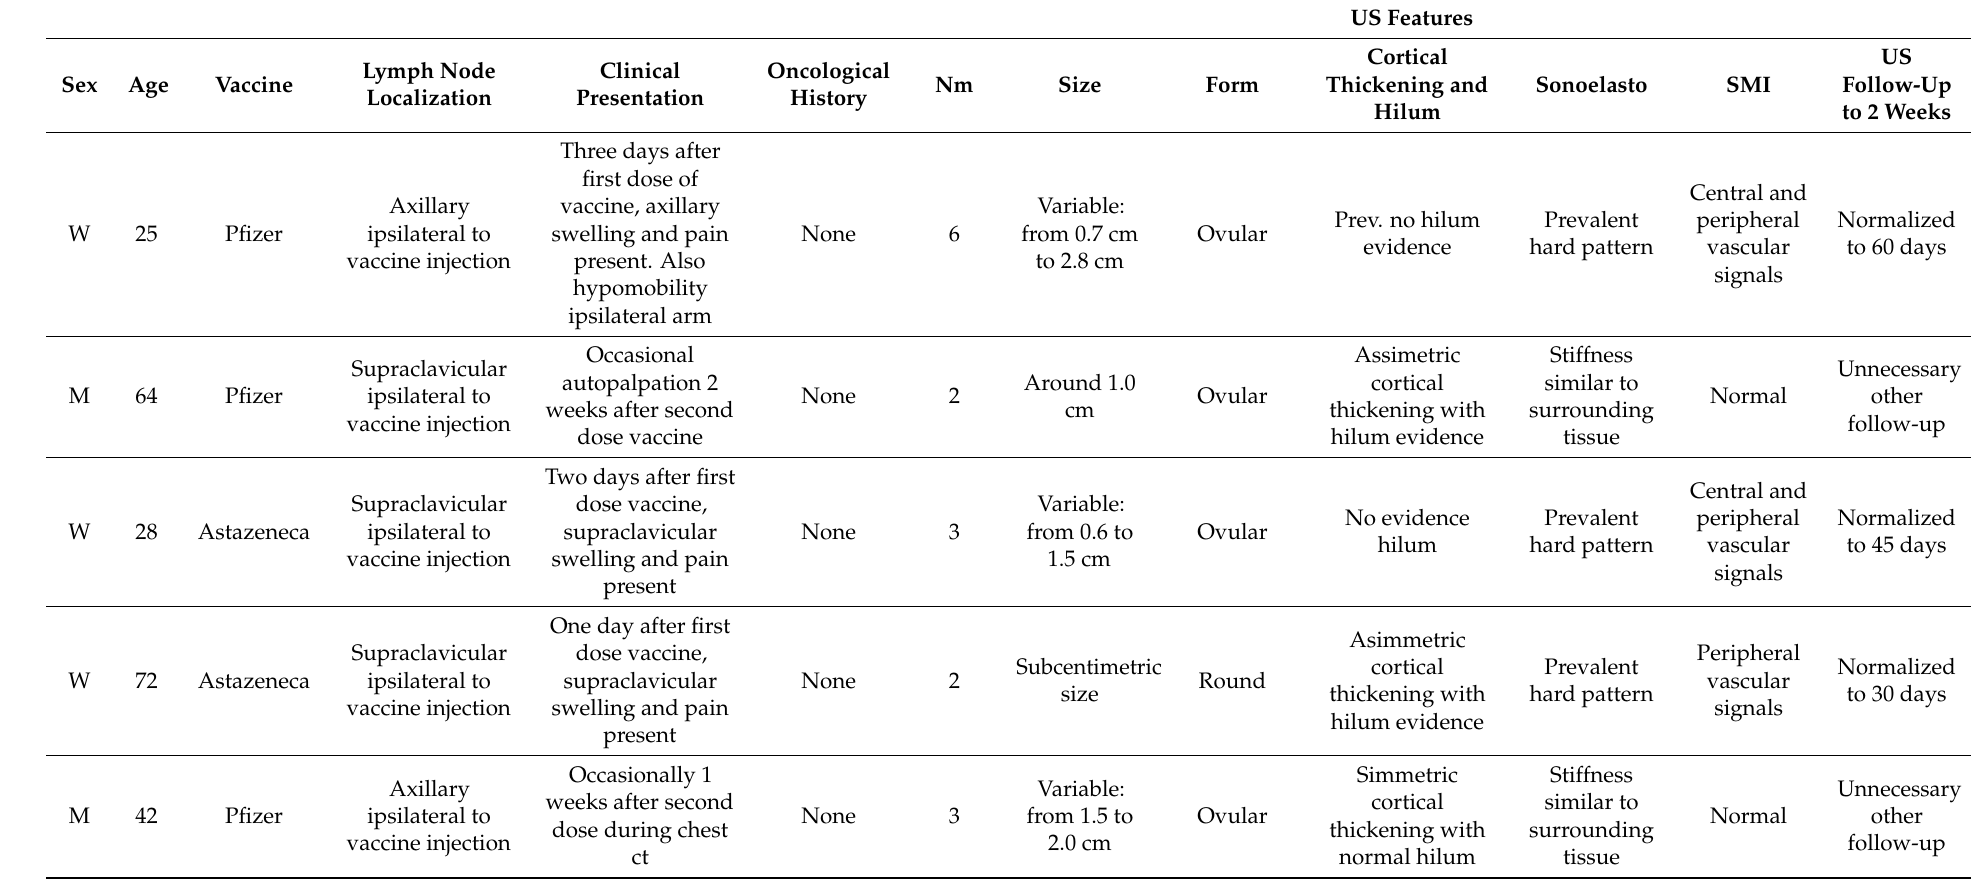
Table 1. Patient study group: clinical characteristics and US